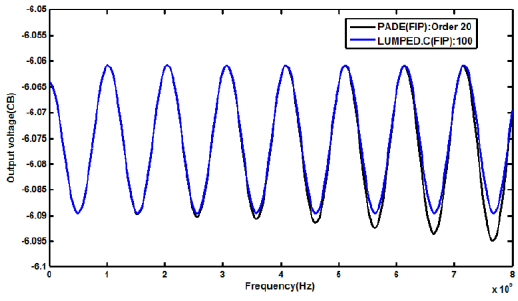
Fig. 8. Frequency response of the circuit shown in